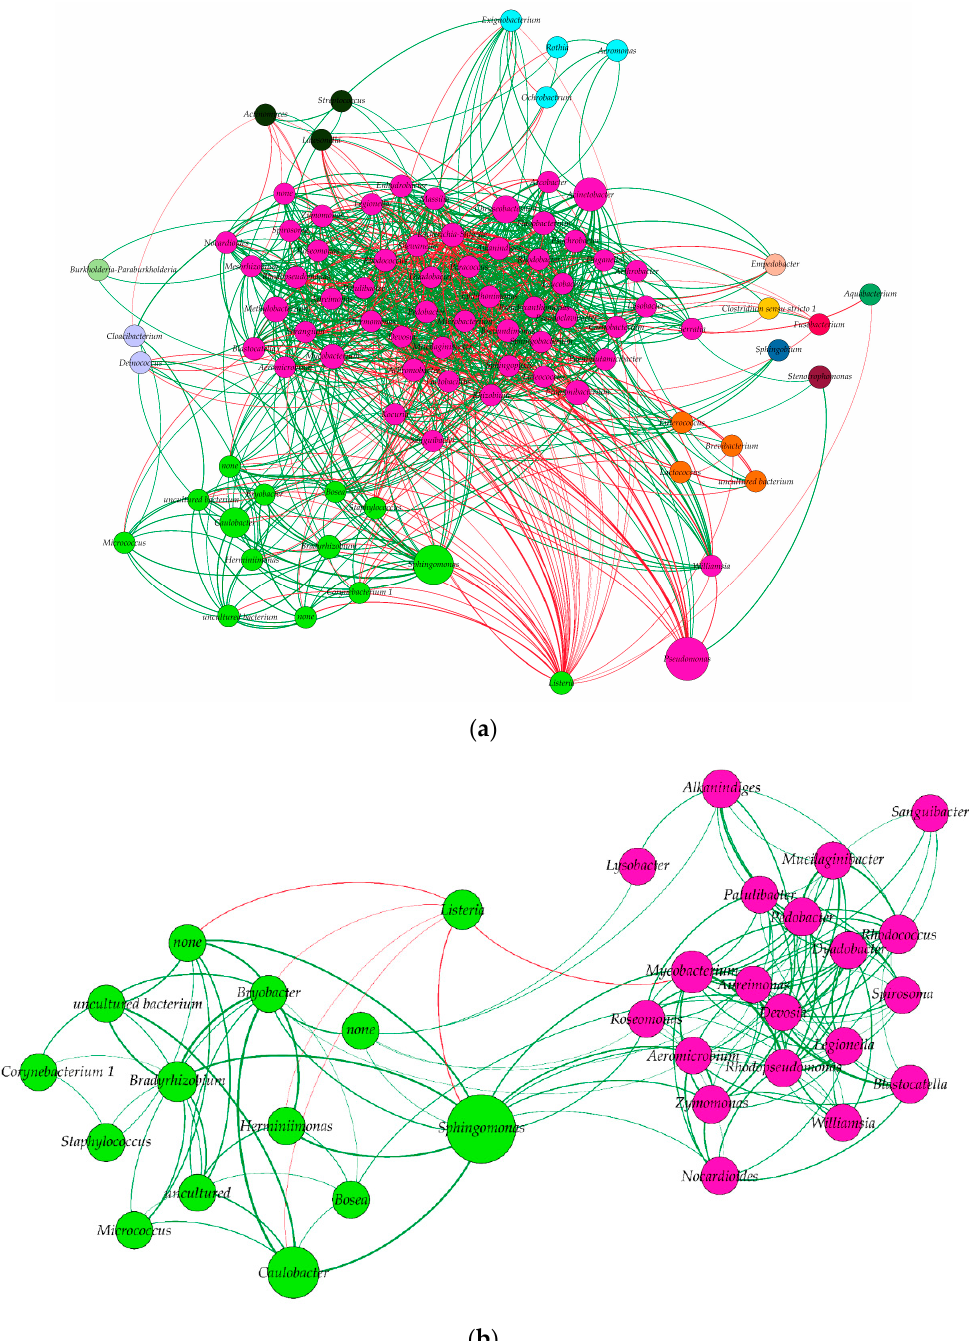
Figure 4. Network construction based on Spearman correlation, Bray–Curtis dissimilarities, and Kullback–Leibler dissimilarities. ( a ) General network of all associations between genera clustered according to constant Potts model (communities sharing most links between each other). The size of each node refers to the abundance of the genus, the thickness of the link refers to its weight (presented here by the Spearman correlation coefficient), and the color of each node refers to positive (green) and negative interactions (red), ( b ) Network construction based on the direct associations between Listeria genus and the other genera and indirect associations between those genera and others. Links colored in red represent negative associations between the genera while green links represent positive associations. The node labelled “none” refers to the unidentified genus from the Elusimicrobia